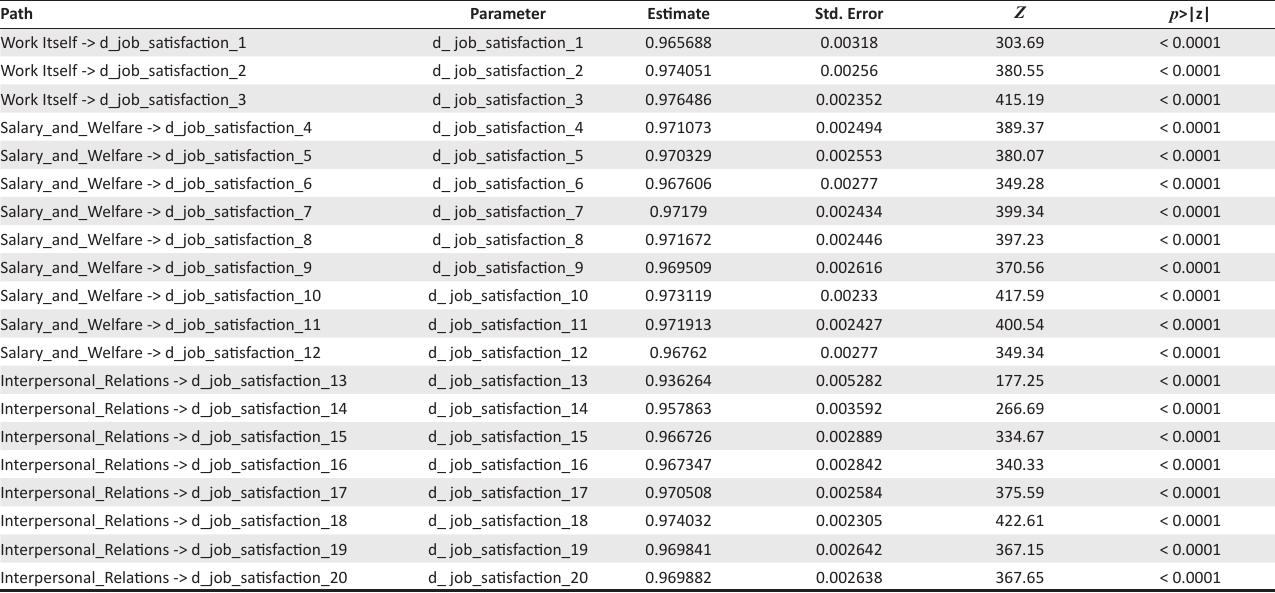
TABLE 3: Path coefficients. Path Parameter